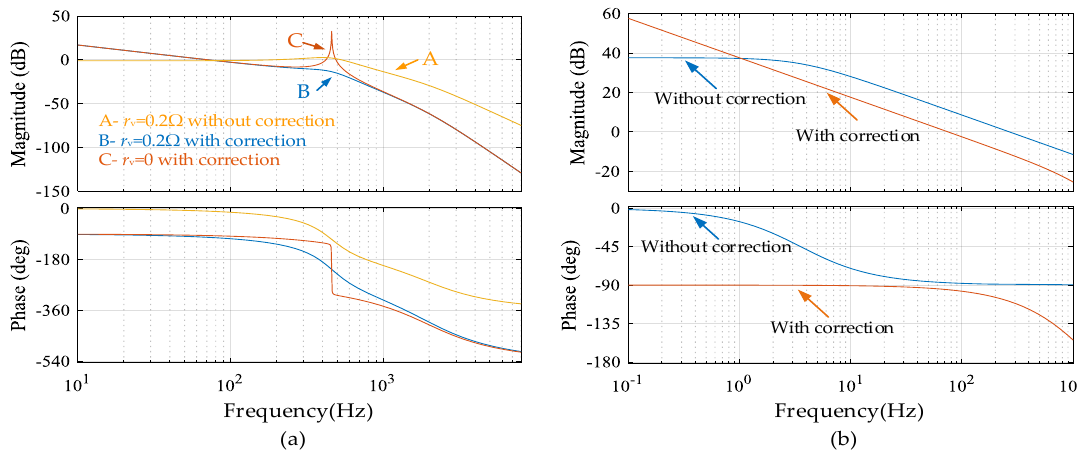
Figure 4. The bode plots of subsystems by using traditional frequency control method: ( a ) i ds subsystem; ( b ) v d2 subsystem.